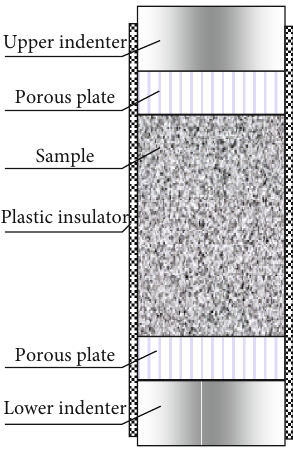
Figure 5: Sealing of rock sample.